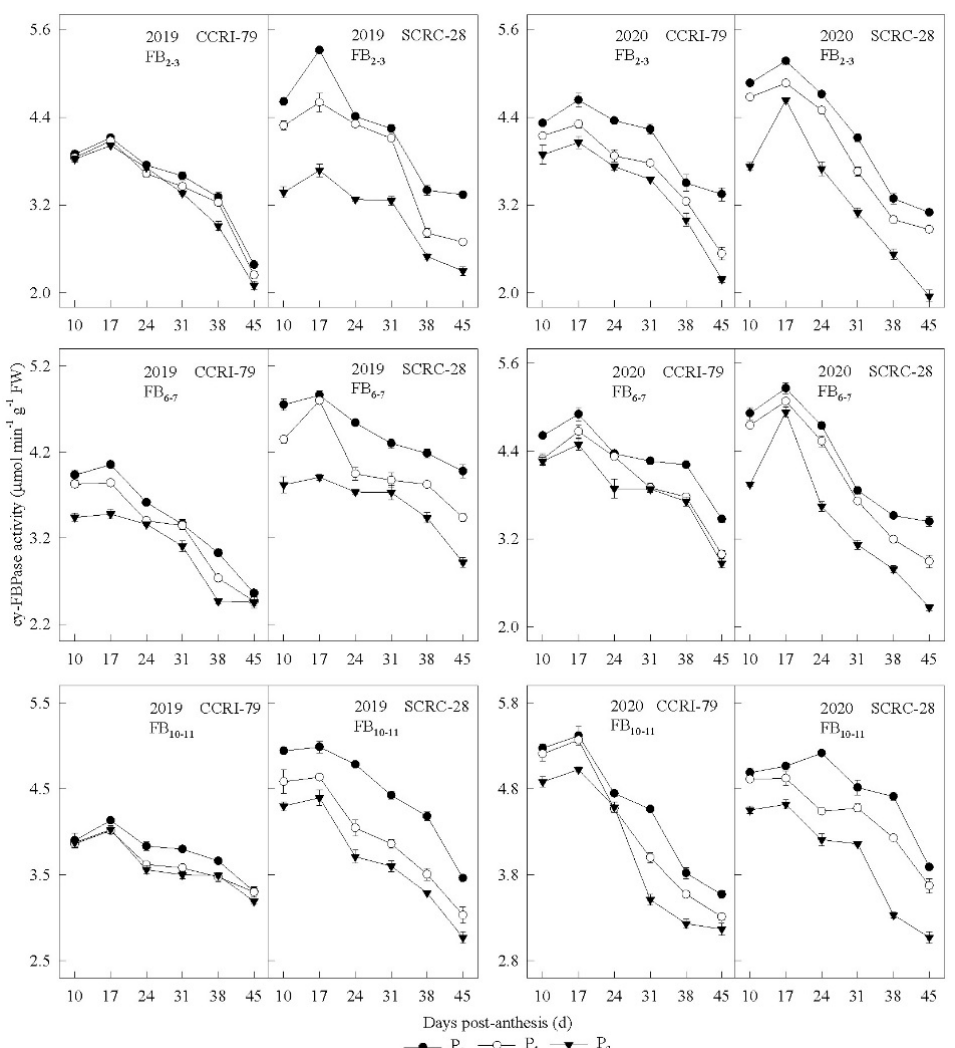
Figure 8. The effect of soil available phosphorus (AP) on the cytosolic fructose-1,6-bisphosphatase (cy-FBPase) activity of subtending leaves in 2019 and 2020 cotton-growing seasons. d: day. FB: fruiting branch. P 0 : 3 ± 0.5 mg kg − 1 . P 1 : 6 ± 0.5 mg kg − 1 . P 2 : 15 ± 0.5 mg kg − 1